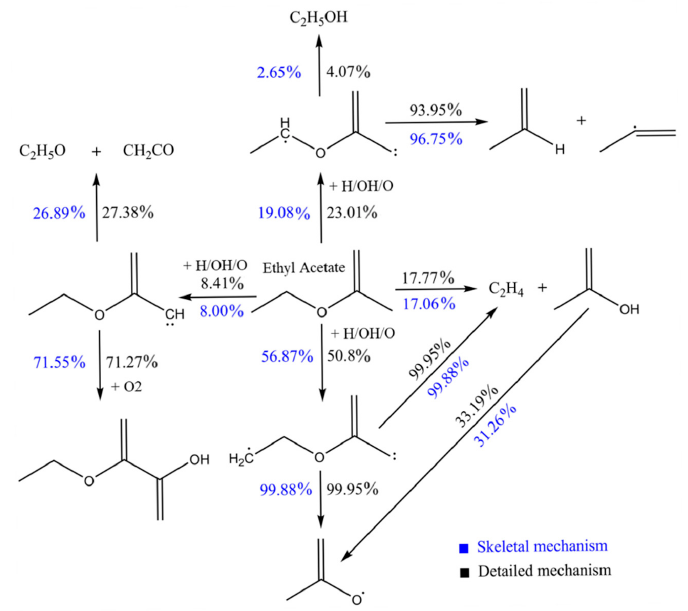
Figure 10. Comparison of the main reaction paths of EA calculated with the skeletal and the detailed mechanisms at ϕ = 1.1. Table 2. Rate of production for main species and reactions calculated by the skeletal mechanism at ϕ = 1.1. Species Reaction